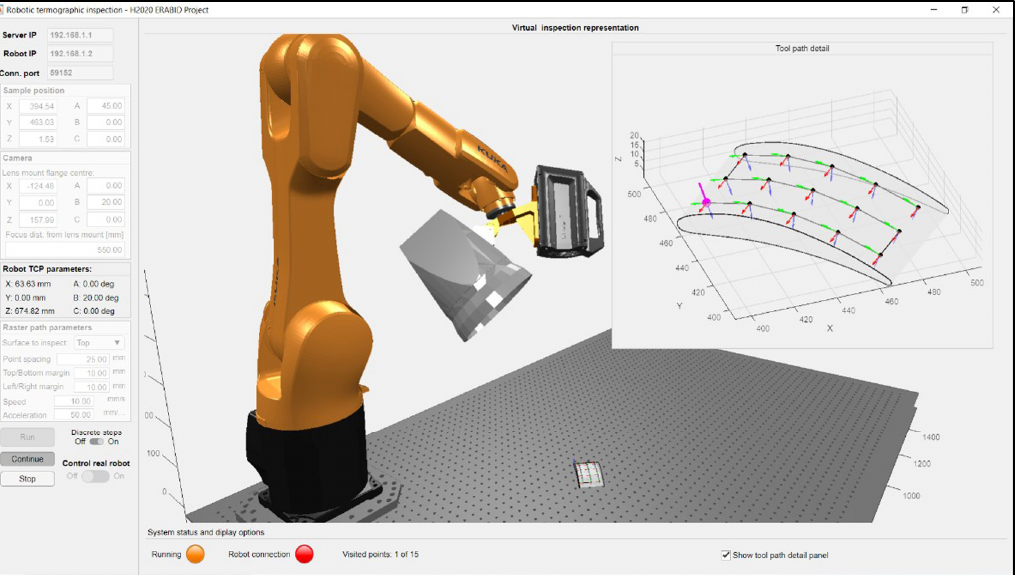
Figure 7. MATLAB-based graphic user interface for robot path-planning, simulation and control.